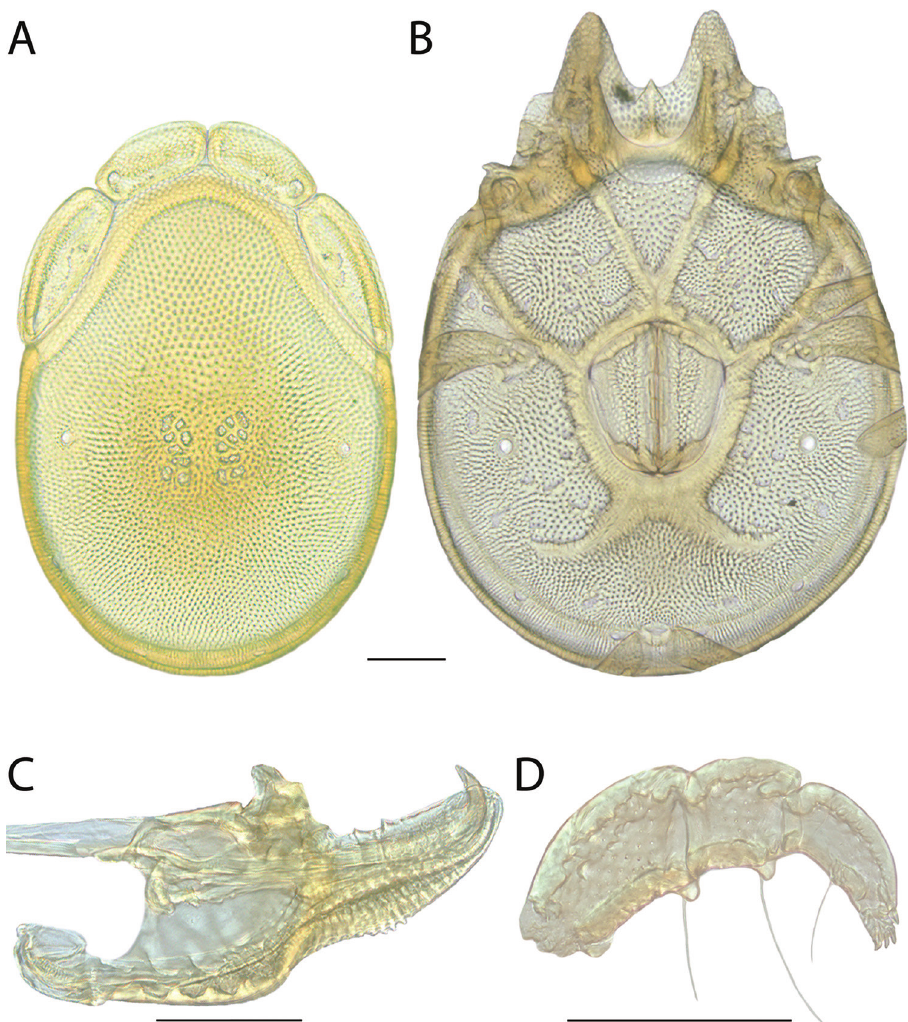
Figure 109. Torrenticola karambita sp. n. female: A dorsal plates B venter (legs removed) C subcapitu- lum D pedipalp (setae not accurately depicted). Scale = 100